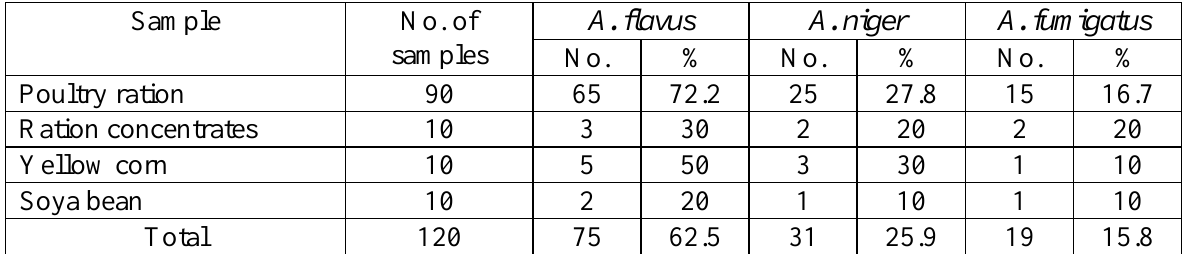
Table 5: Incidence of different Aspergillus spp . in the different examined samples: